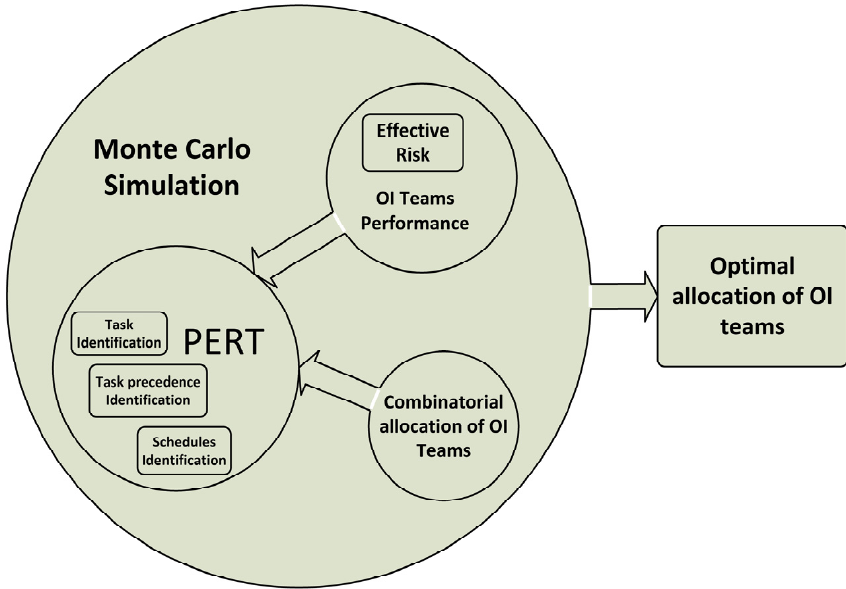
Figure 4. Conceptual representation of the proposed model.